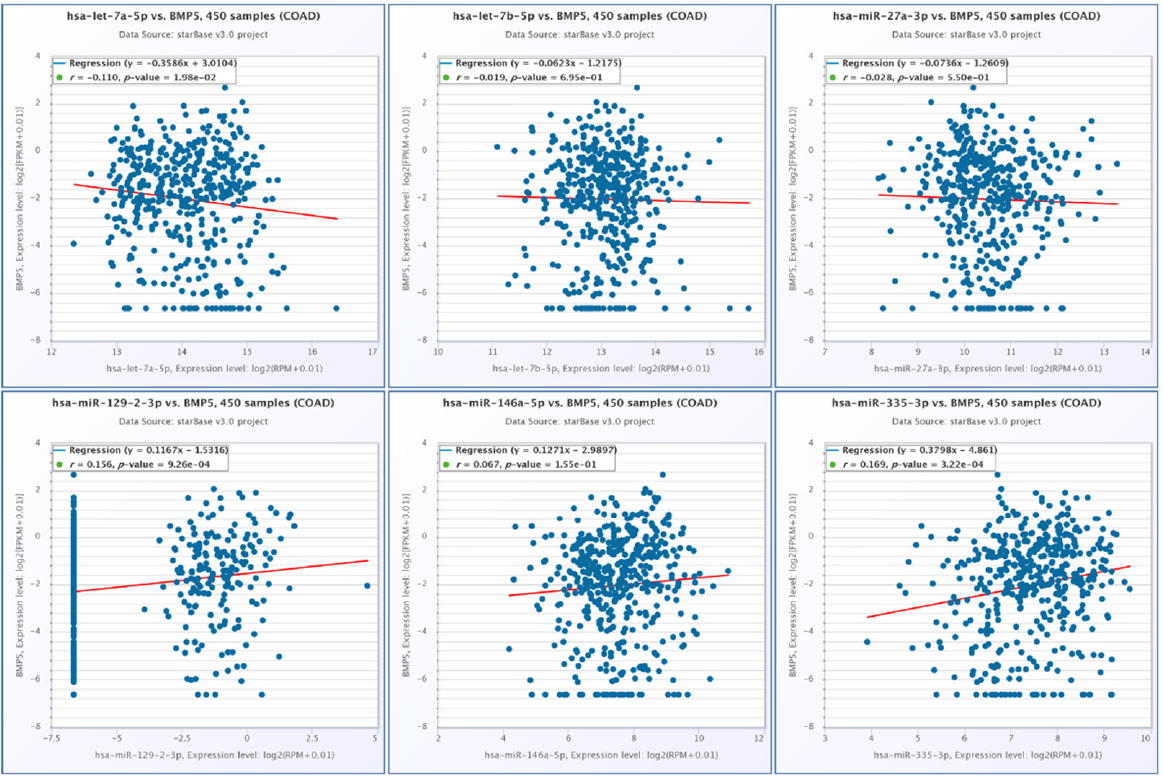
Figure 7. Correlation among the expression levels BMP5 and let-7a-5p, let-7b-5p, miR-27a-3p, miR-129-2-3p, miR-146a-5p and miR-335-3p in COAD, generated using StarBase.